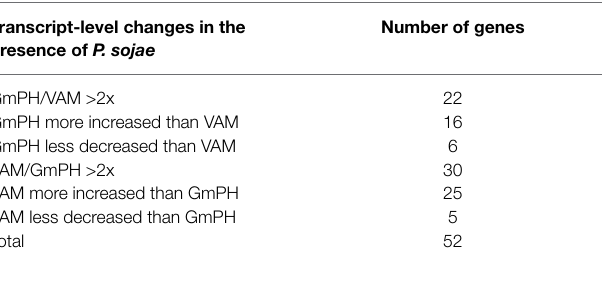
TABLE 3 | Differential transcript-level changes in the presence of Phytophthora sojae. Transcript-level changes in the presence of P. sojae